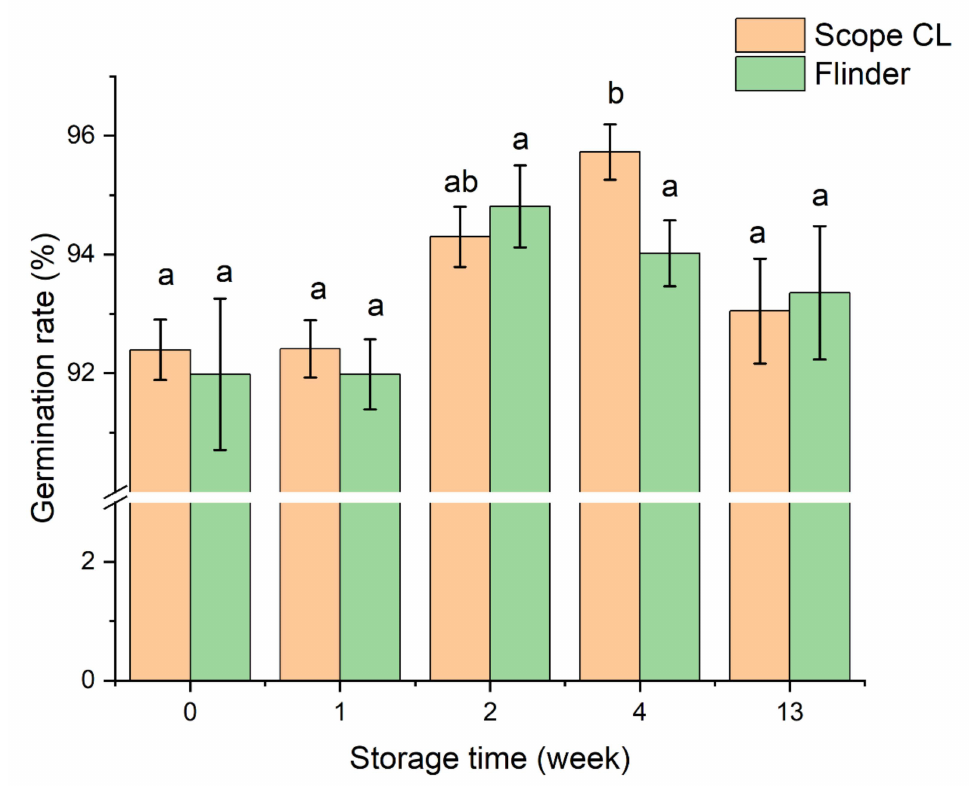
Figure 1. Effect of storage time on barley germination in Scope CL and Flinder varieties. 424 (eight replicates of 53 seeds) of each treatment were utilized. The data represent the average of eight replications, and the bars represent standard errors. Bars with different letters in each varieties are significantly different (Tukey’s HSD test, p < 0.05).